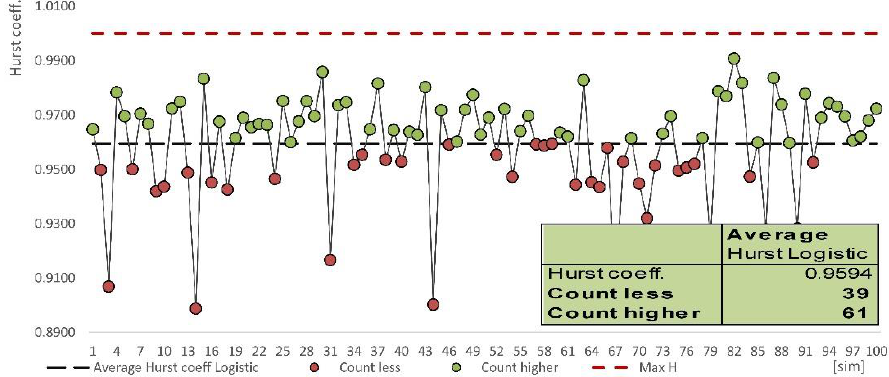
Figure 8. Value under- and above-average Hurst coefficient (logistic variant). (Source: authors).